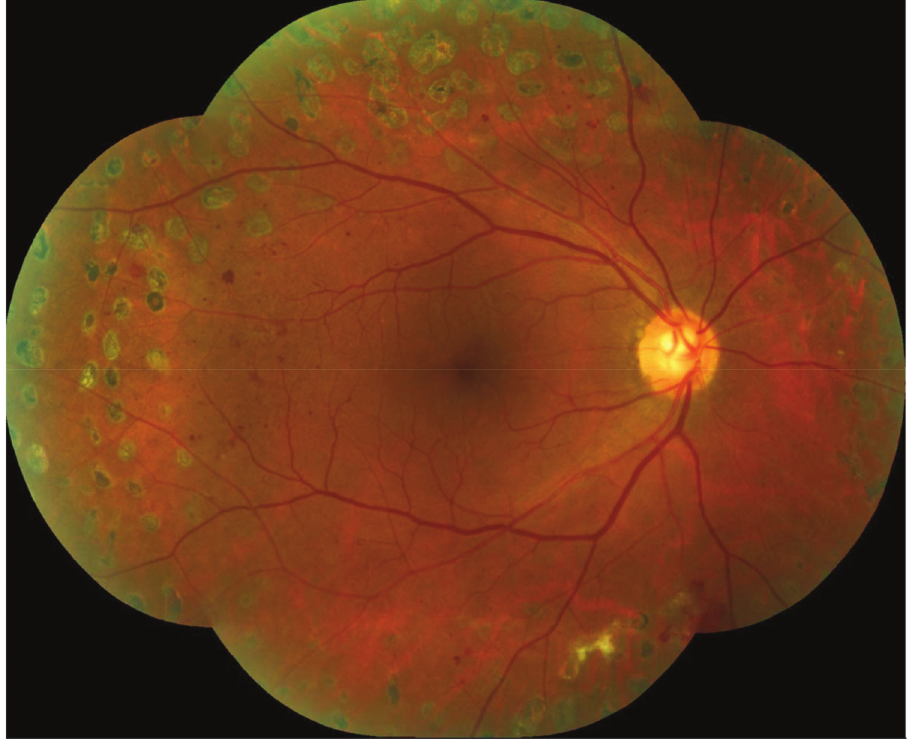
Figure 3 - Retinography (montage) of the posterior pole and mid periphery exemplifying the pattern of laser photocoagulation performed in the